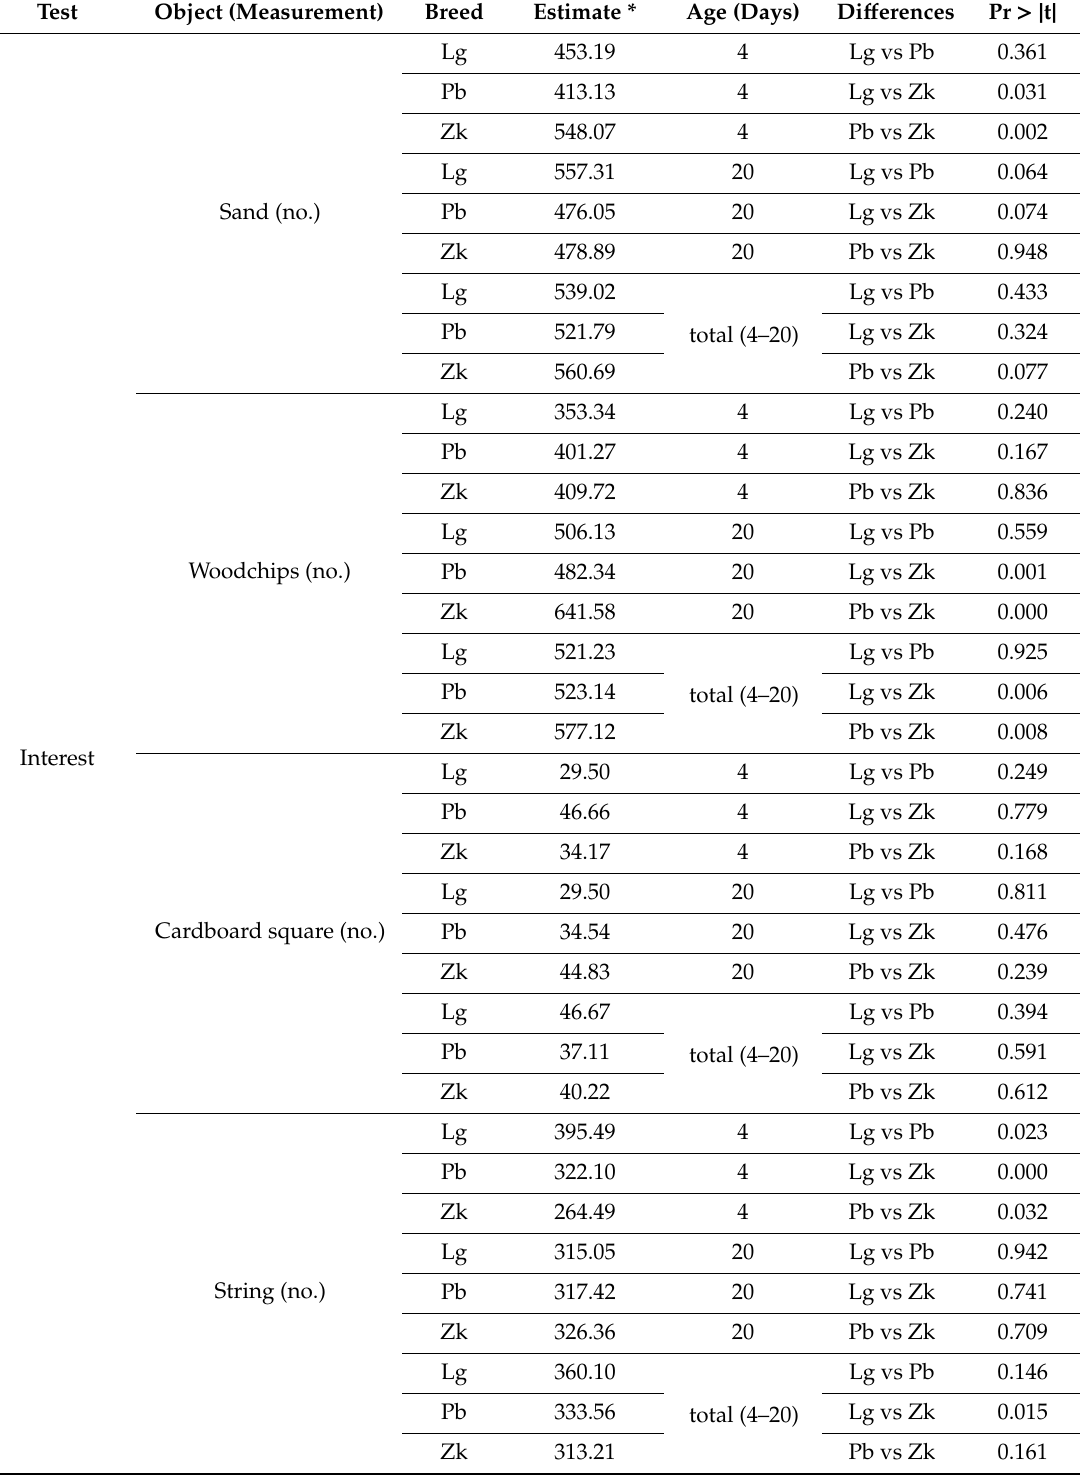
Table 5. Mean level of analysed indicators* and significance of di ff erences between the means in the Interest test in relation to the breed and age of